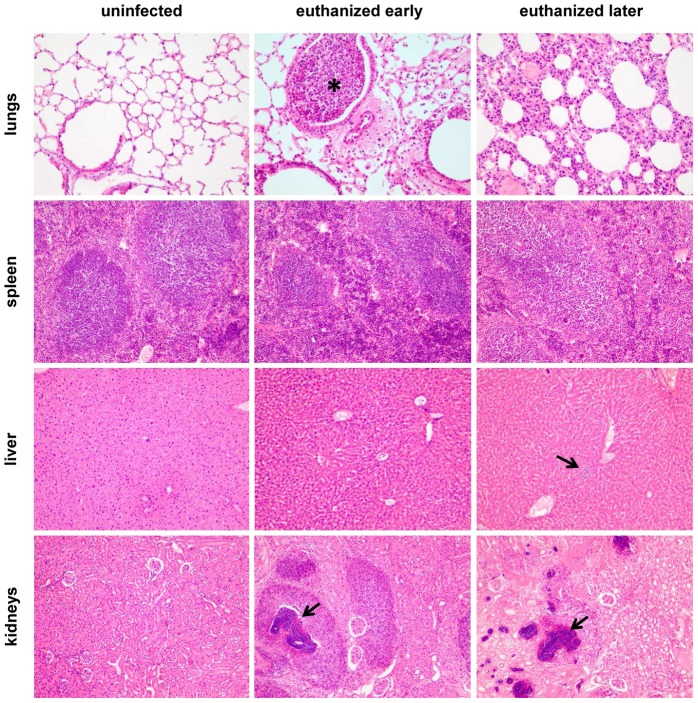
Representative histopathological features in lungs, spleen, liver and kidneys of mice with S. aureus bacteremia.Haematoxylin and eosin stained tissue sections are shown. Lungs (200×), spleen (100×), liver (100×), and kidneys (100×). Uninfected mice; mice with S. aureus bacteremia that were euthanized early (day 4-5); mice with S. aureus bacteremia that were euthanized later (day 10–11). In lungs, asterisk indicates bronchopneumonia with neutrophils. In liver, arrow indicates hepathic microabscesses with neutrophils. In kidneys, arrows indicate abscesses in kidneys.